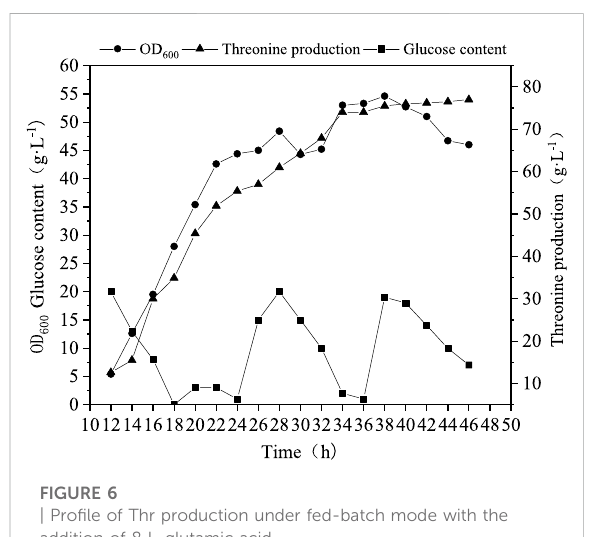
FIGURE 6 | Pro fi le of Thr production under fed-batch mode with the addition of 8 L-glutamic